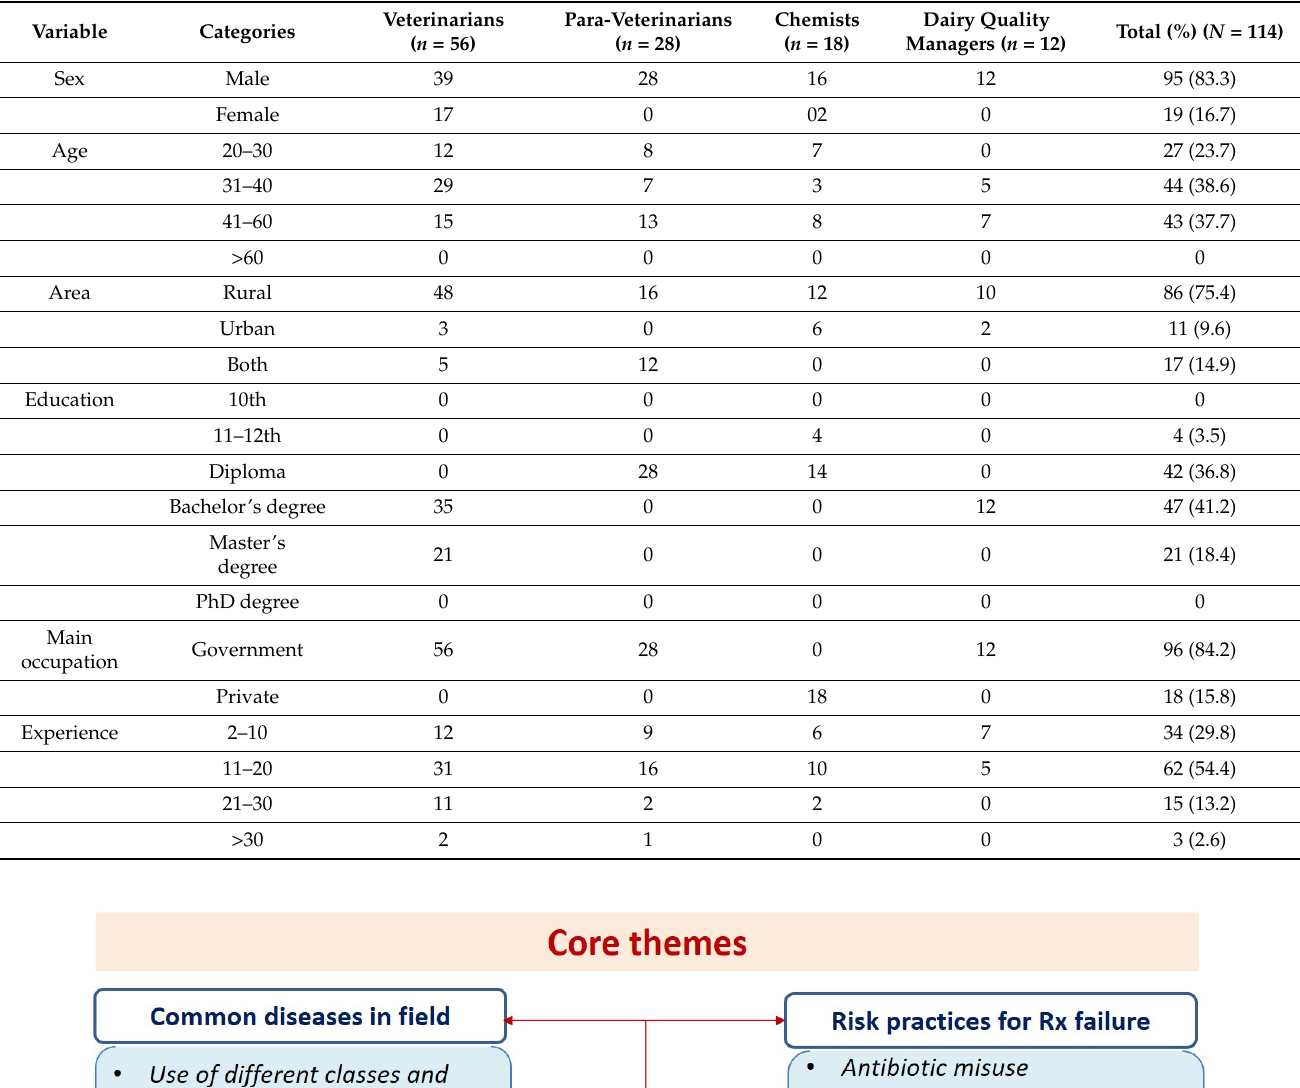
Table 1. The demographic characteristics of the study participants.